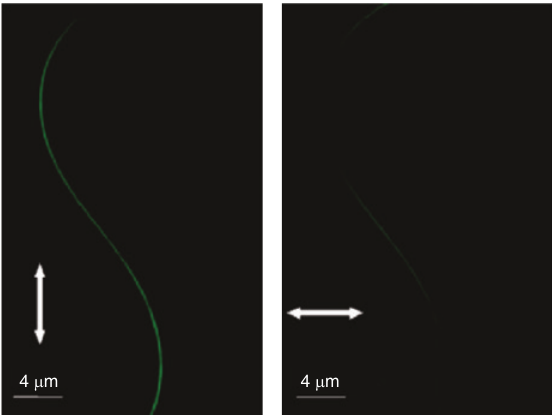
Figure 11: Scanning electron micrographs in parallel with schematic drawings demonstrating the optical interactions and behaviors of dye-doped PMMA fibers and/or beads. In bottom right corner of far right cartoons images, the observed emission under excitation is shown. (Reprinted with permission from Kim et al. ACS Appl. Mater. Interfaces, 5, 6038, © 2013 American Chemical Society).